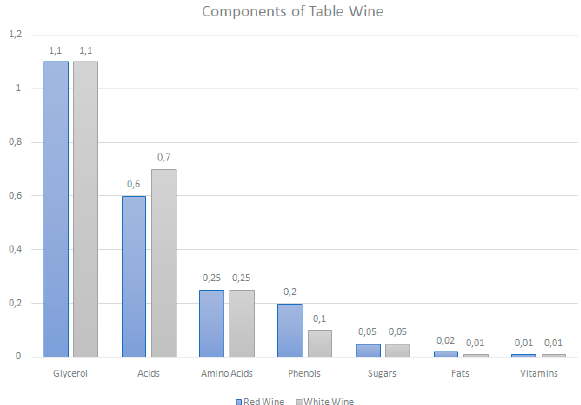
Figure 3. Components of table wine. Estimates of typical gross composition (percentage weight).